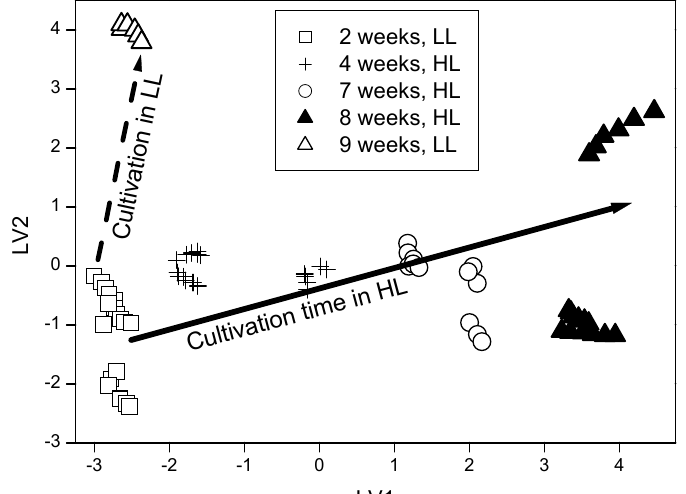
Figure 7. PCA plot of unmodified and modified API samples–eudragit modification changes chemical images of API in the same direction [45]. Ibu–pure ibuprofen; Ibu-Hypr–ibuprofen modified by hypromellose; Ibu-Eud–ibuprofen modified